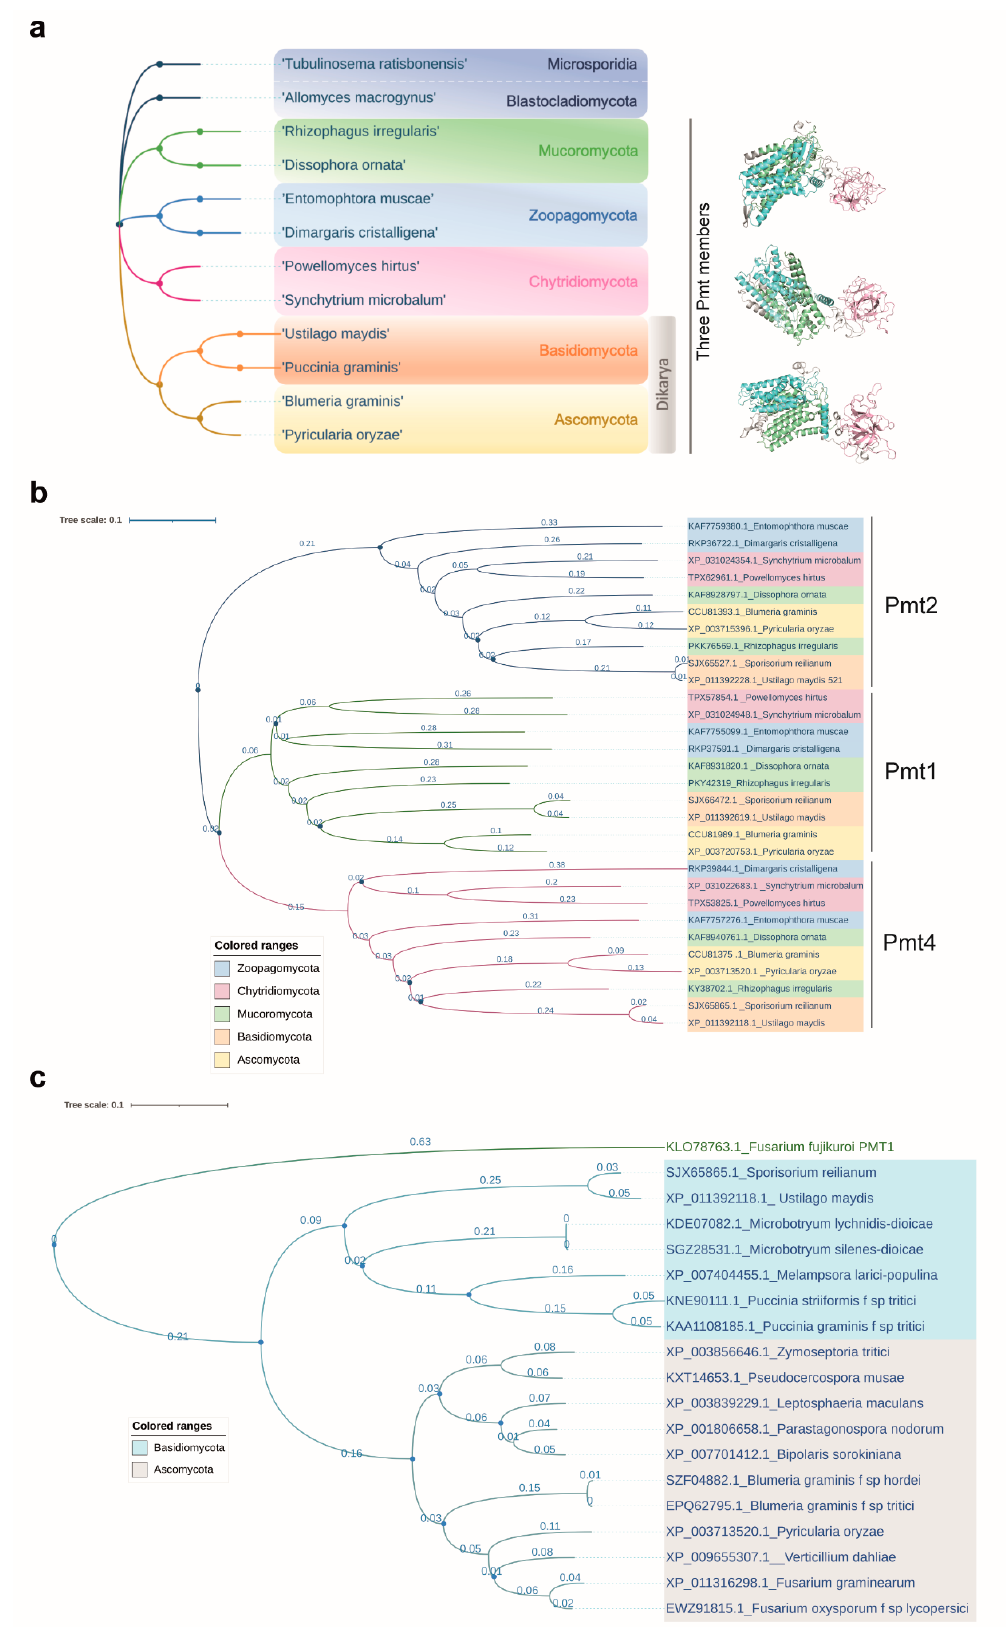
Figure 4. The Pmt family is commonly composed of three members in fungi. ( a ) Most fungal clades harbour three